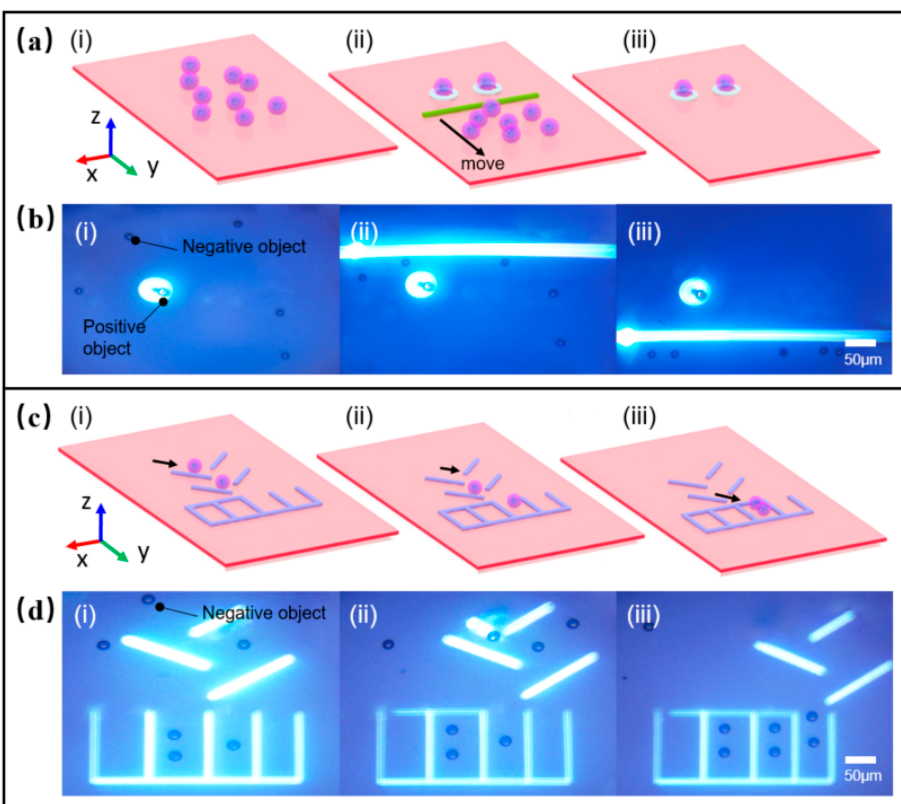
Figure 11. Sorting or storing the microparticles via OET. ( a ) Schematic of sorting microparticles via OET; ( b ) Images of sorting microparticles; ( c ) Schematic of storage microparticles; ( d ) Images of storage microparticles via OET.